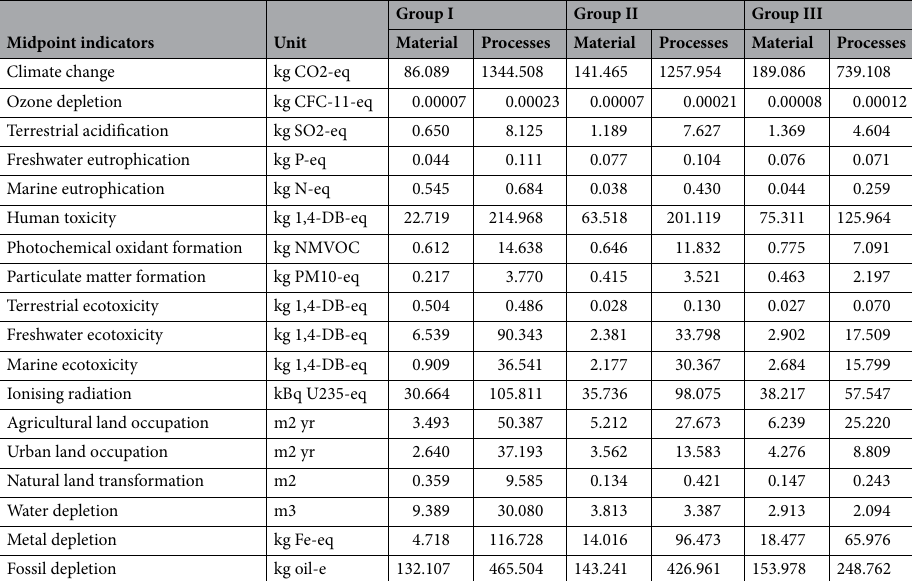
Table 5. Characterization factors of the ReCiPe Midpoint environmental analysis in area